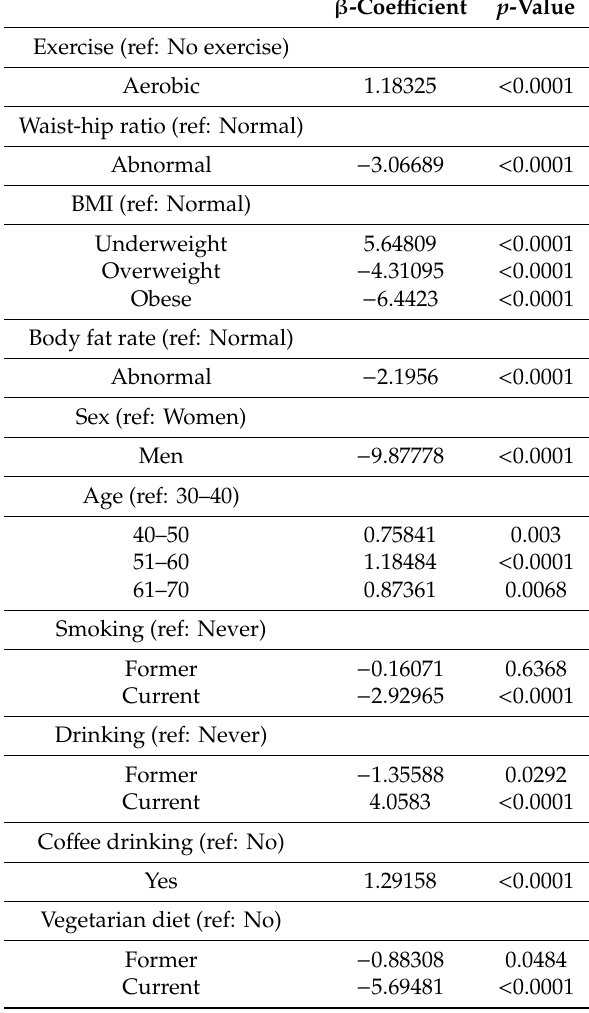
Table 3. Overall e ff ect of aerobic exercise, WHR, and BMI on HDL-C